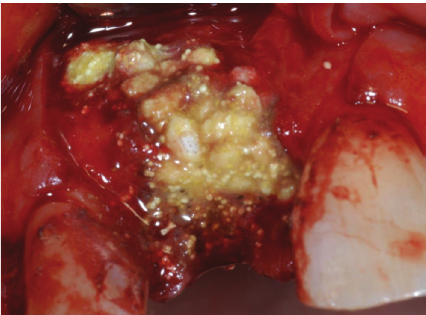
Figure 6: Granules of synthetic, micromacroporous BCP, mixed with tetracycline powder, were applied to completely fill and cover the bone defect.